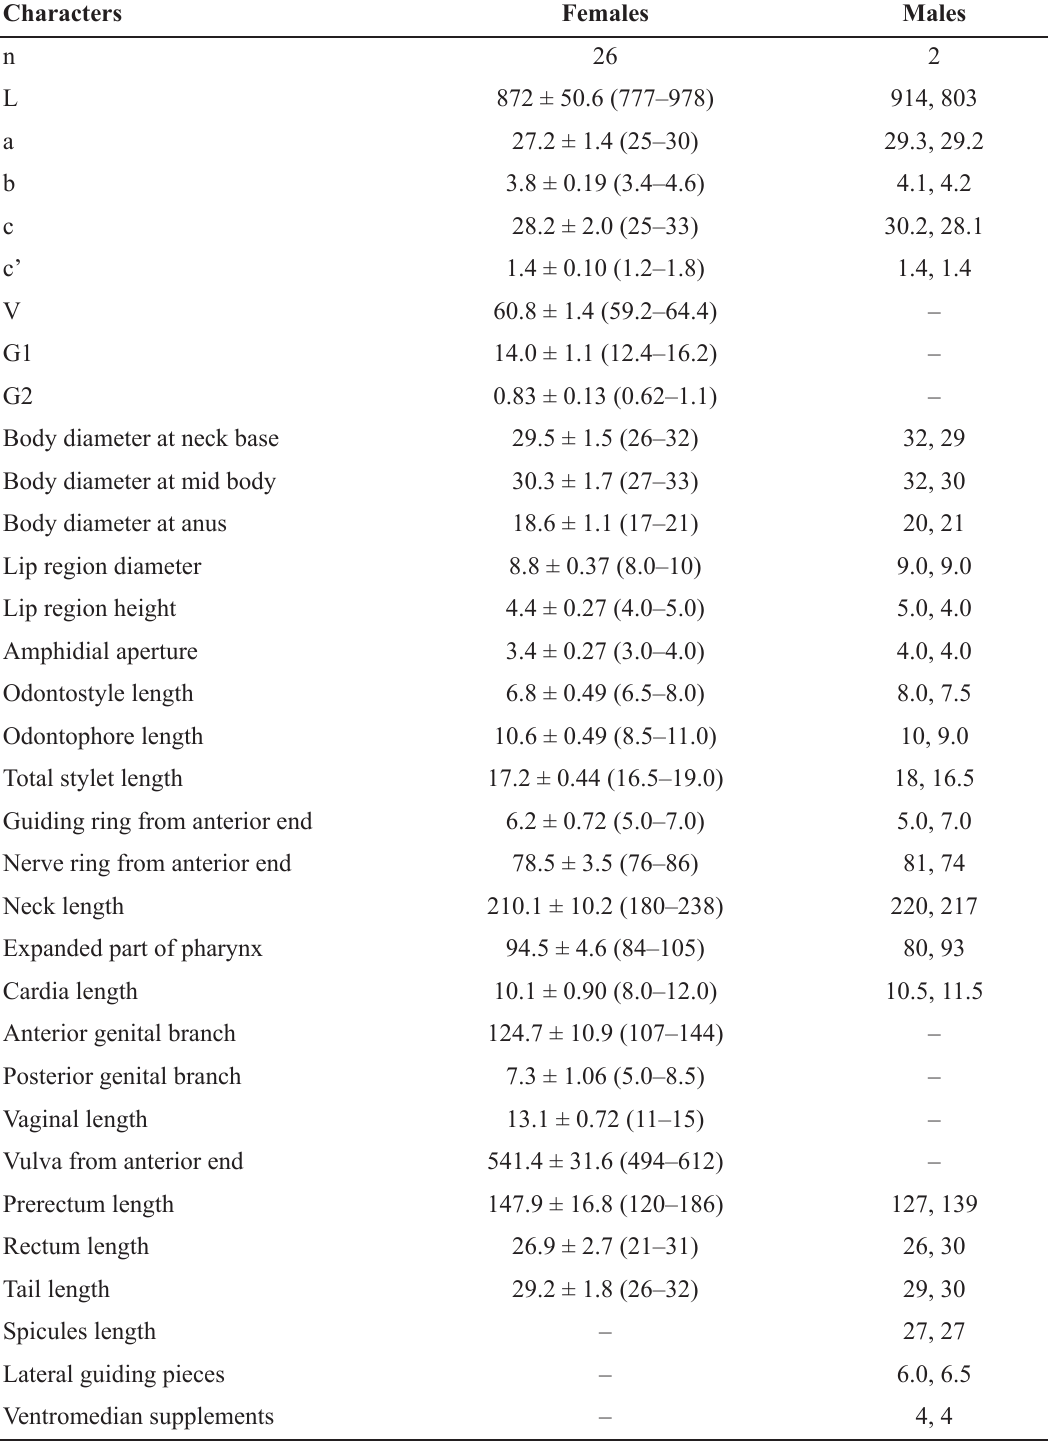
Table 1. Measurements of Tylencholaimus mirabilis (Bütschli, 1873). All measurements are in μm and in the form: mean ± s.d. (range) for females, and measurements for each male (n = 2) separated by a